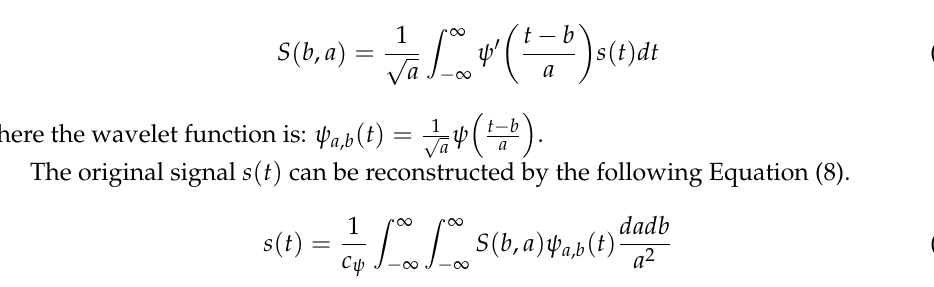
Figure 8. Double threshold method for zero interval detection in nine-hole peg test.